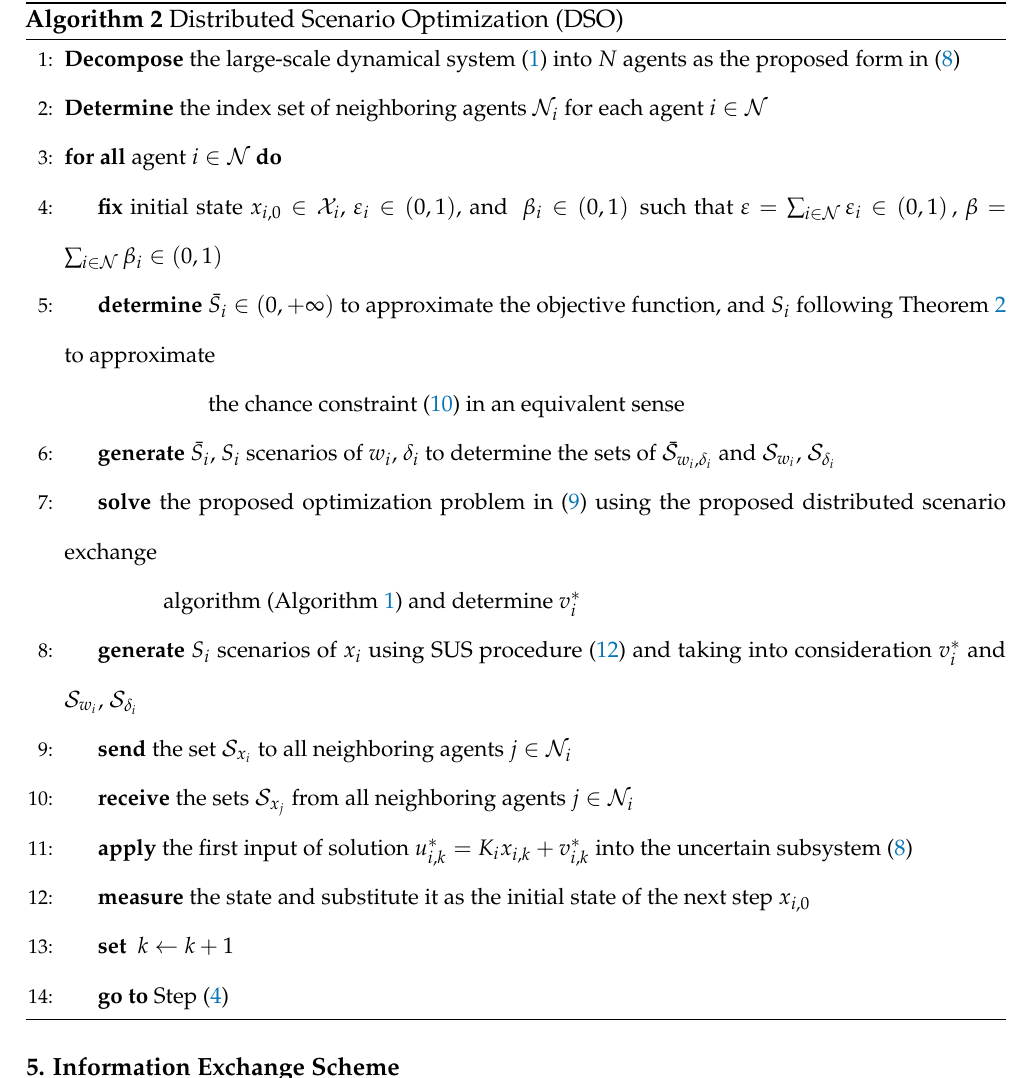
Algorithm 2 Distributed Scenario Optimization